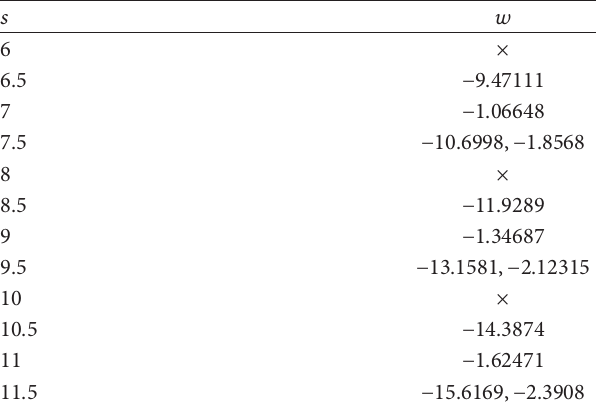
Table 2: Approximate solutions of 𝐸 (ℎ) 𝑞 (𝑠, 𝑤) = 0, ℎ = 3, 𝑤 ∈ R